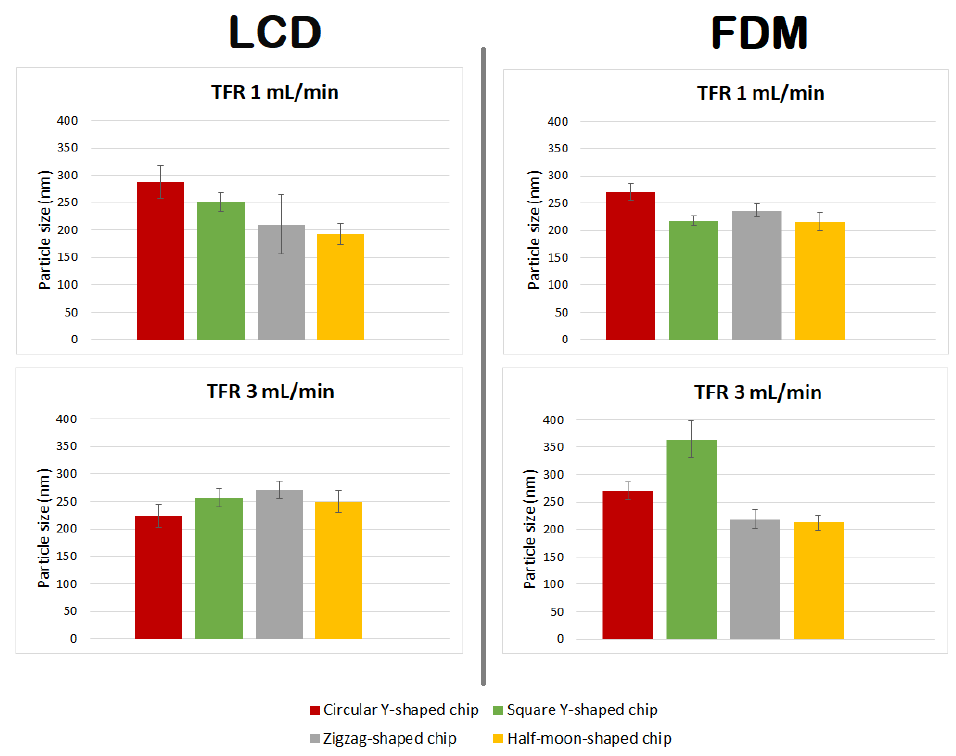
Figure 9. Comparison of particle size of DMPC liposome formulations prepared using circular Y-shaped, square Y-shaped, zigzag-shaped, and half-moon-shaped chips at TFRs of 1 and 3 mL min − 1